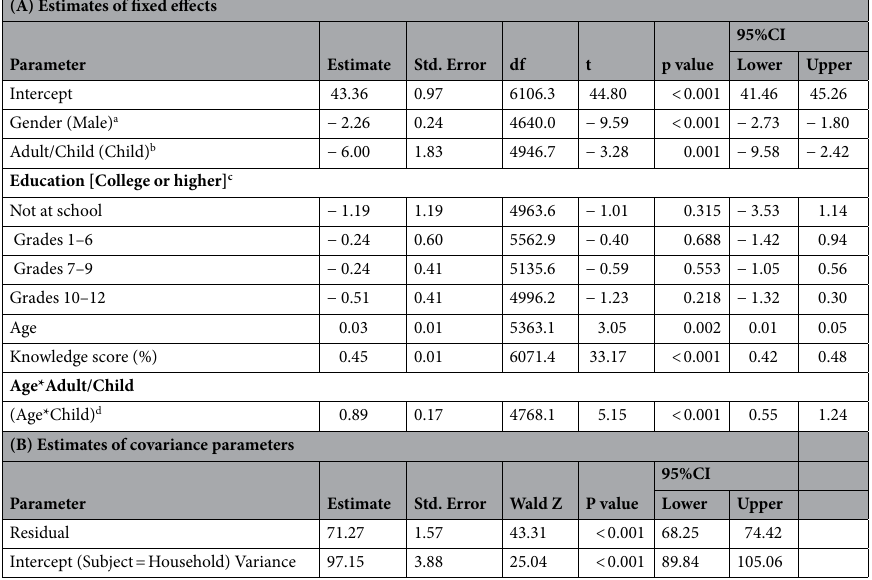
in Table 5B show that both residual (individual characteristics) and intercept (household variations) covari- ances are significant (both p < 0.001), which indicated that behavior scores vary between households and among